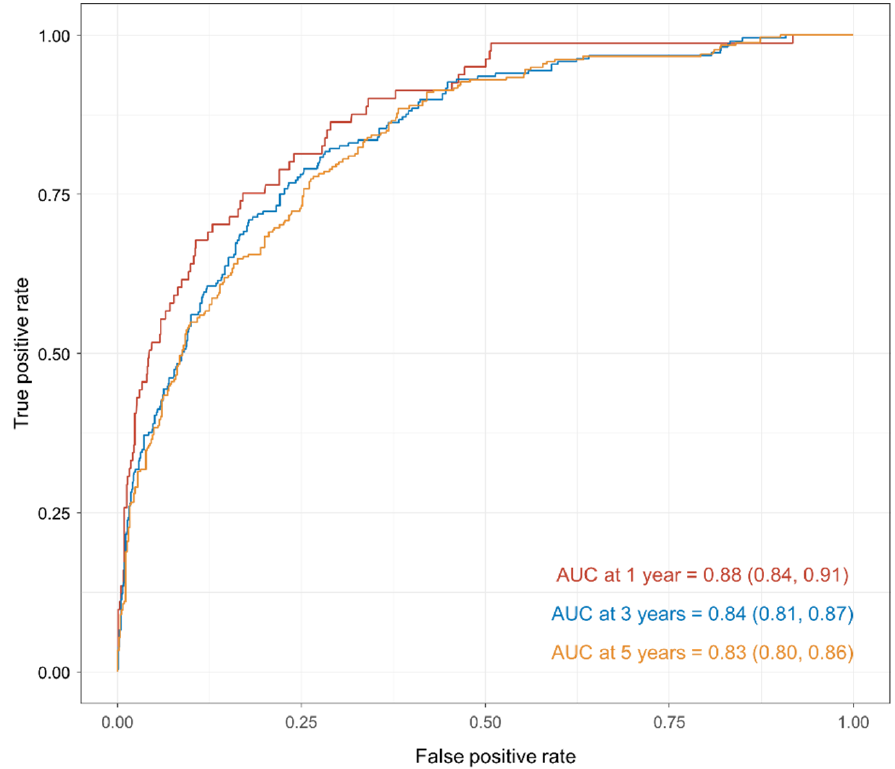
Figure 3. Time-dependent receiver operating curves on the 1-year, 3-year, and 5-year model perfor- mance in the validation set.